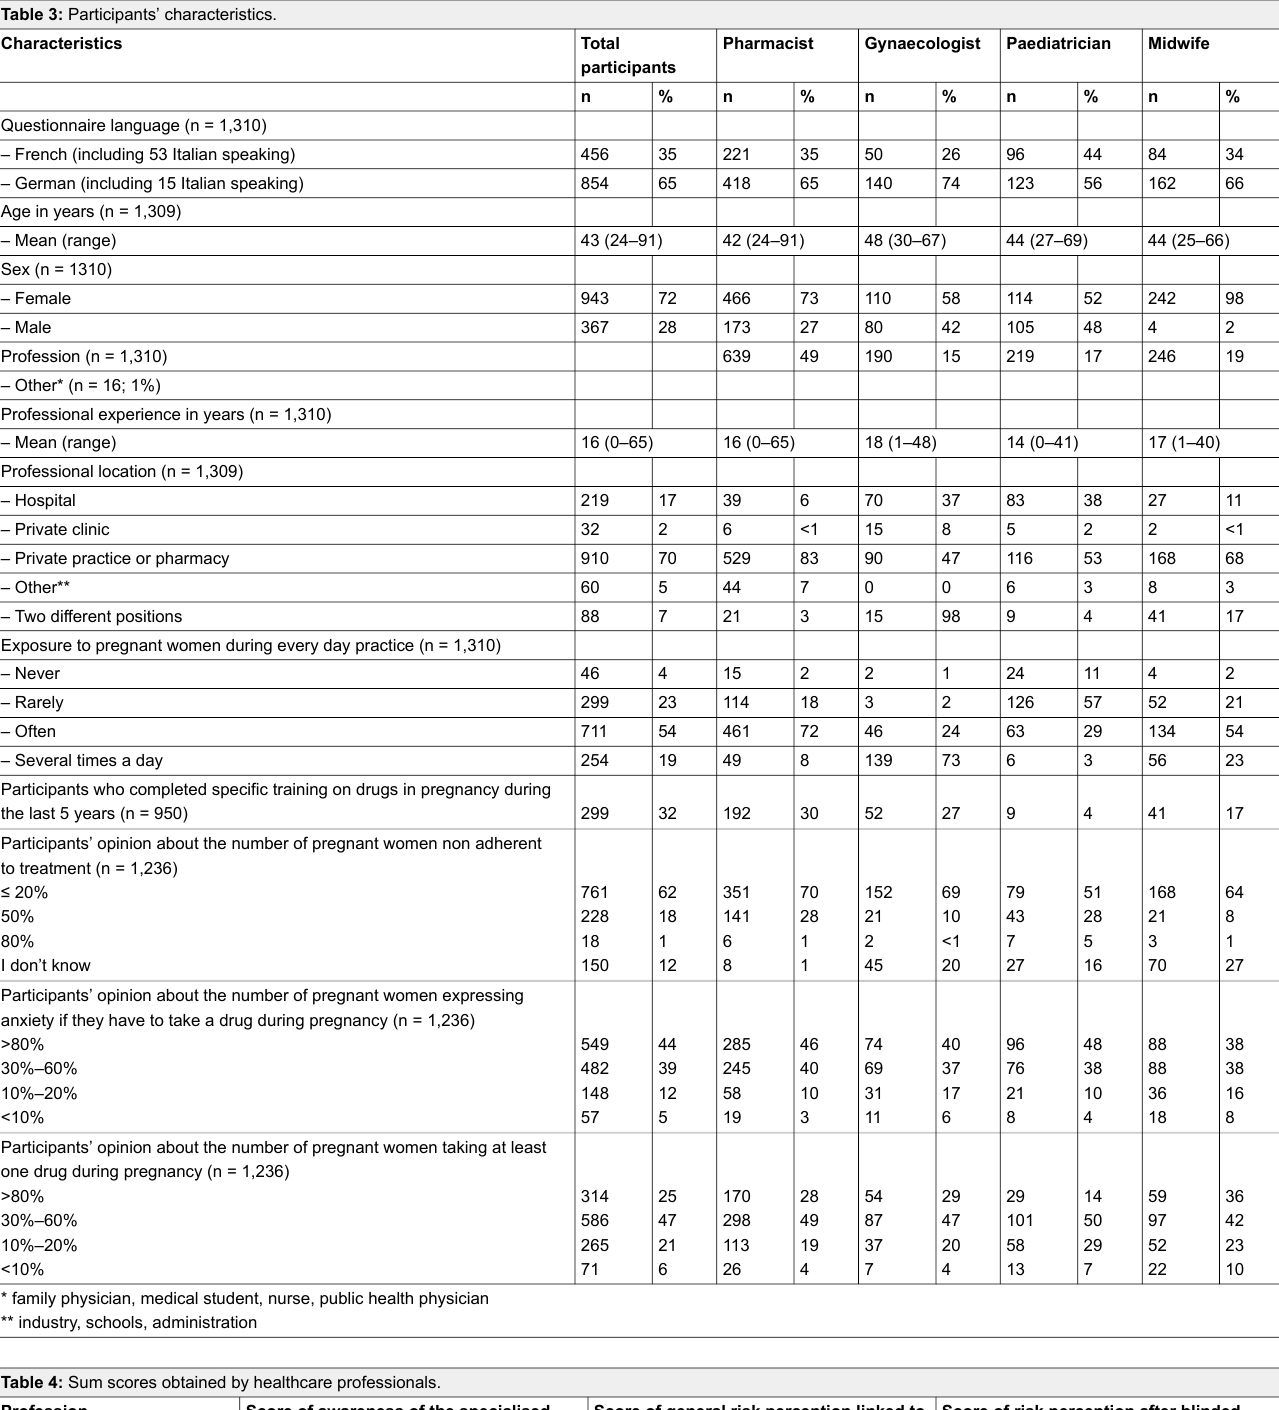
Score of awareness of the specialised information sources (n = 733) Lowest score= 0 Best score = 3 Mean (95% confidence interval)